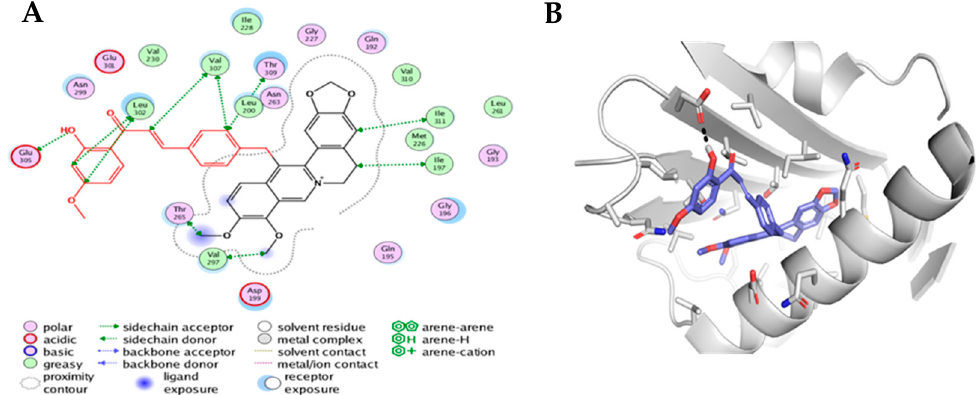
Figure 5. ( A ) Binding mode of compound 25 depicted as a 2D diagram. The figure was produced using the “Ligand interaction” feature of MOE. ( B ) The proposed binding mode of compound 25 in the S. aureus FtsZ protein. Compound 25 and surrounding protein sidechains are displayed in stick representation. The backbone from the protein is shown as cartoon. The picture was generated using Pymol (http://pymol.org) software.